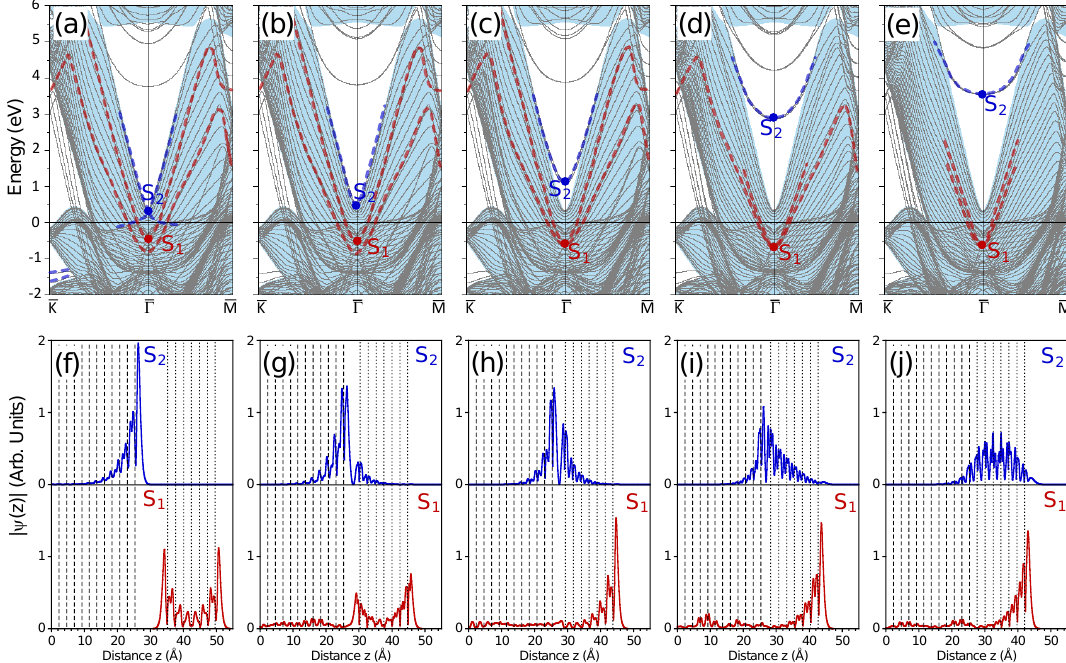
Figure 4. Electronic structure of the 7 ML Au/Pt(111) surface at ( a ) 10 Å, ( b ) 5 Å, ( c ) 4 Å, ( d ) 3 Å, and ( e ) the equilibrium distance between the top Pt and closest Au atomic layers. The surface states discussed in the text are marked as S 1 and S 2 . Panels ( f – j ) present respectively the in-plane averaged charge density distributions of the S 1 (red) and S 2 (blue) surface states. In ( f – j ), vertical dashed (dotted) lines show the positions of the Pt (Au) atomic layers. The central atomic layer of the 23 ML Pt slab is placed at